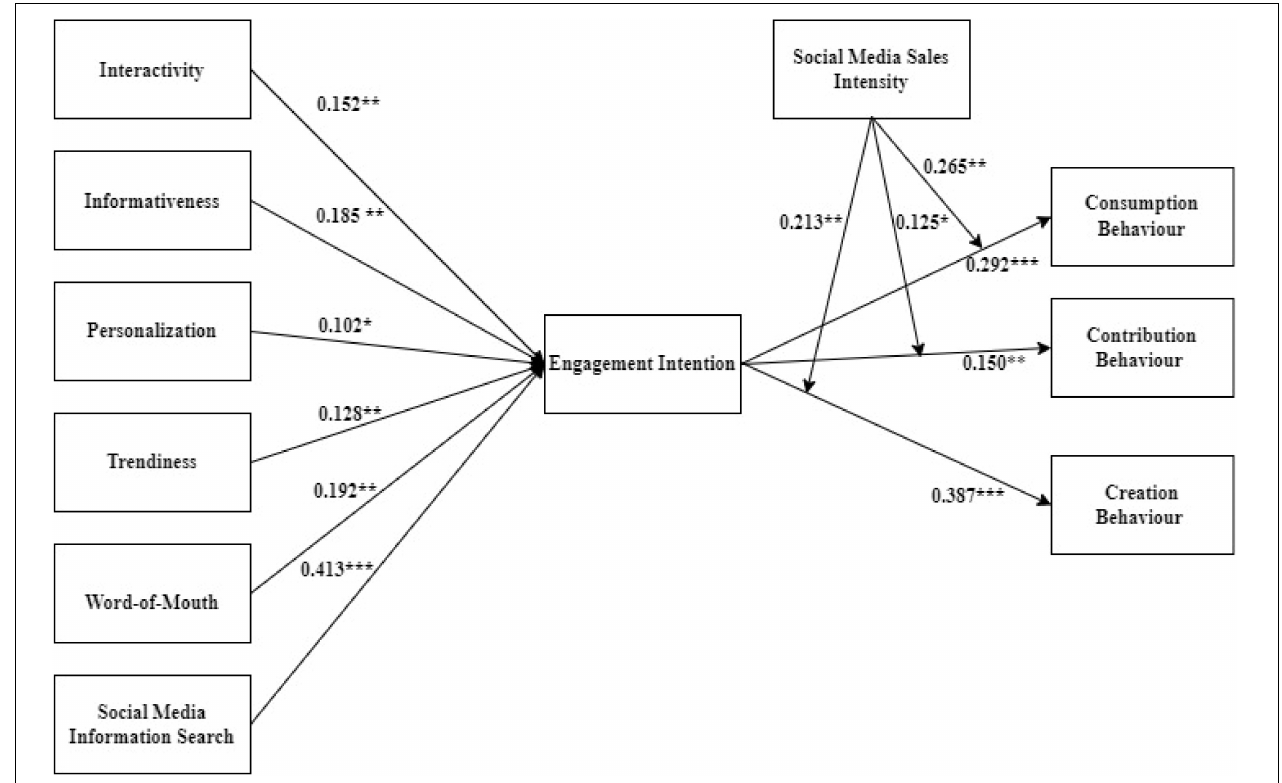
FIGURE 2 | Path analysis results; *** p < 0.001, ** p < 0.01, * p < 0.05.